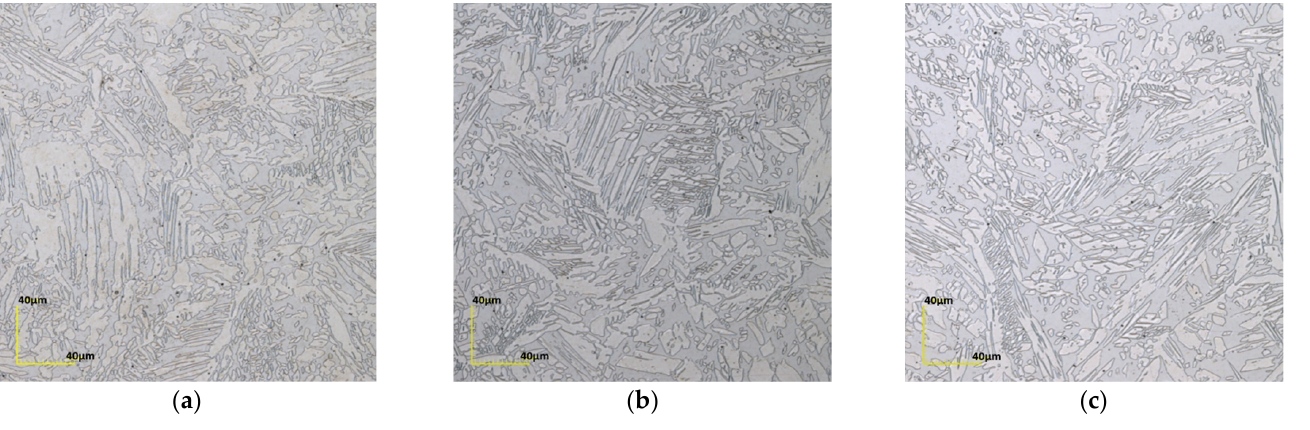
Figure 10. Microstructure observed in the FZ of the sample subjected to postwelding solution heat treatment for 10 s at 1150 °C: ( a ) edge; ( b ) 1/4 region; ( c ) 1/2 region.